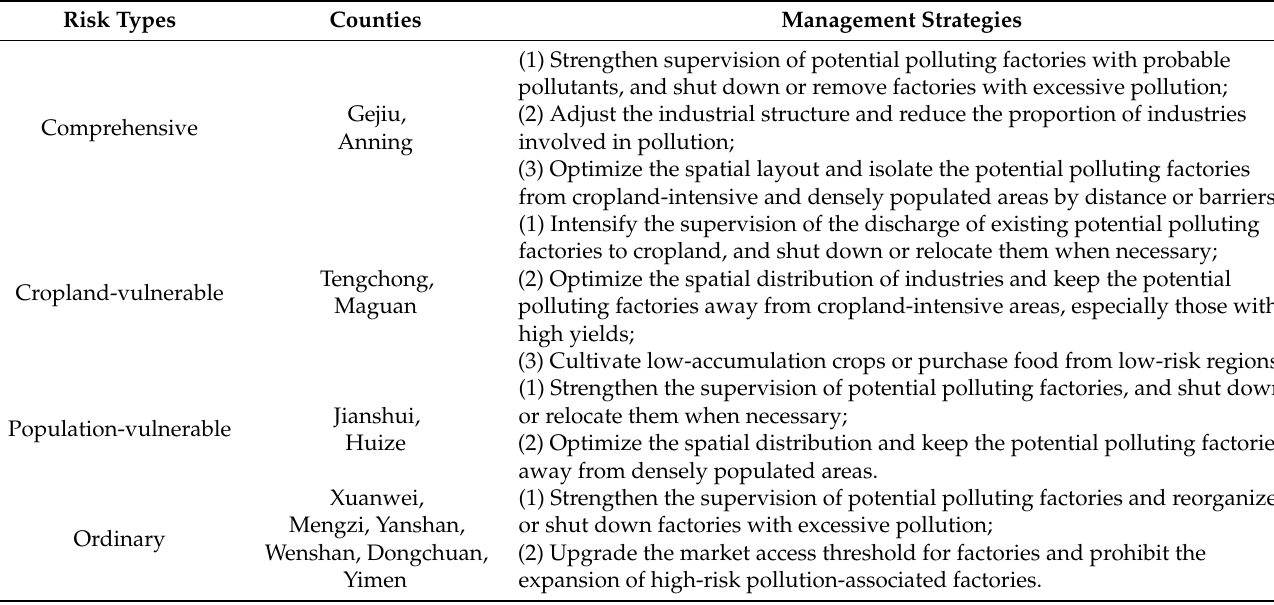
Table 4. Counties associated with different types of risk and the proposed management